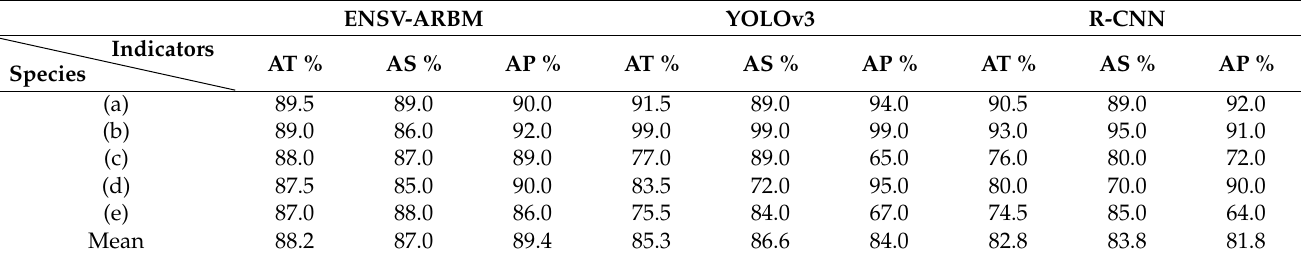
Table 4. Comparison of results between the proposed scheme and other vision